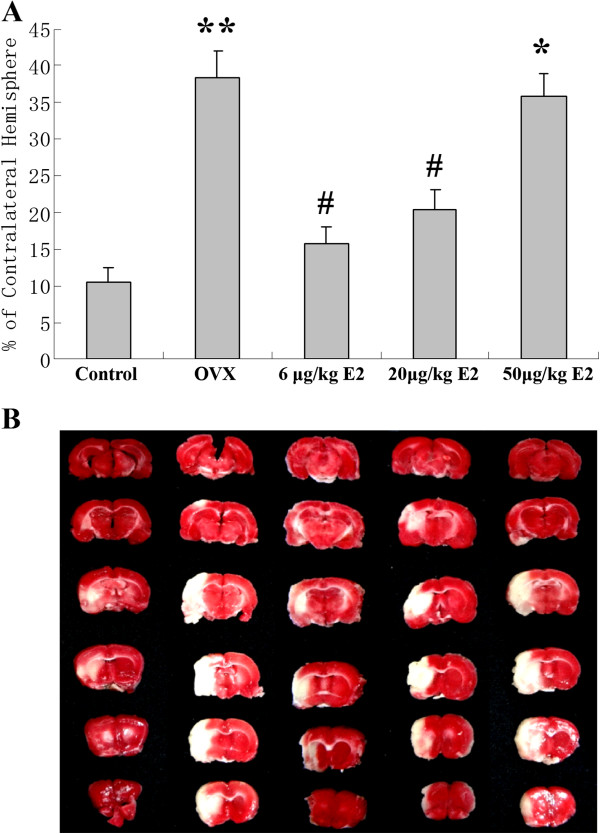
The infarct volume in rats exposed to ischemia–reperfusion injury by MCAO receiving different doses of E2. (A) The OVX group resulted in larger infarct volume compared to the control group. 6 μg/kg and 20 μg/kg E2 replacement significantly decreased the infarct volume. 50 μg/kg E2 replacement group resulted in larger infarct volume than the control group and 6 μg/kg or 20 μg/kg E2 replacement group. (**p < 0.01 v.s. the control group, #p < 0.05 v.s. the OVX group, *p < 0.05 v.s. the control group and 6 μg/kg or 20 μg/kg E2 replacement group). (B) Representative photographs showing infarct volume in the different groups after the MACO.